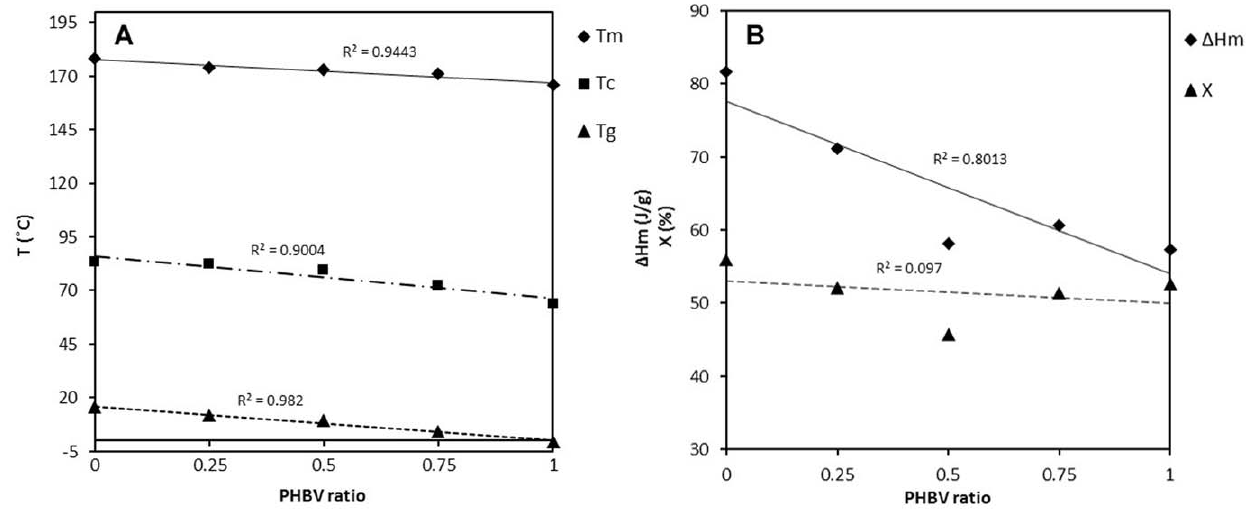
Figure 2. Thermal properties of PHB/PHBV nanofibers versus blend compositions. (A) melting temperatures (T m ), glass transition temperature (T g ) and crystallization temperatures (T c ); (B) melting enthalpy ( D H m ) and crystallization percentage ( x ).